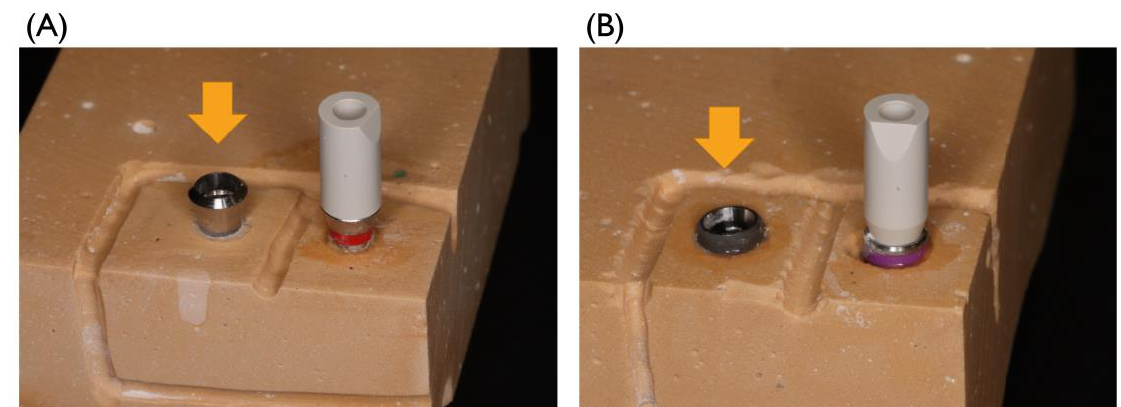
Figure 2. ( A ) The distance between the centers of the top surfaces of the two SBs was measured. ( B ) The angle between the axes of the two SBs was measured.